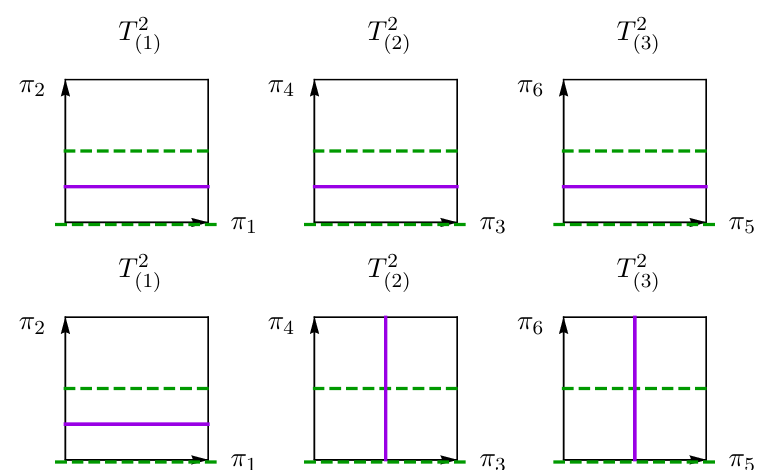
Figure 1 . D6-brane con(cid:12)gurations with codimension 3 intersection preserve a local N = 4 super- symmetry: an example of three-cycles with torus wrapping numbers (1 ; 0; 1 ; 0; 1 ; 0) (above) and an three-cycle example with torus wrapping (1 ; 0; 0 ; 1; 0 (cid:0) 1) (below). The O6-planes are represented by the dashed, green